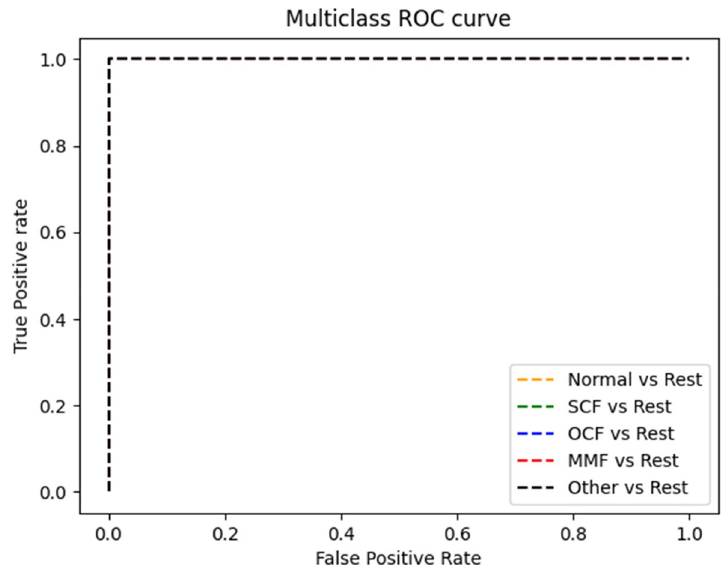
Fig. 7 ROC curves for the five